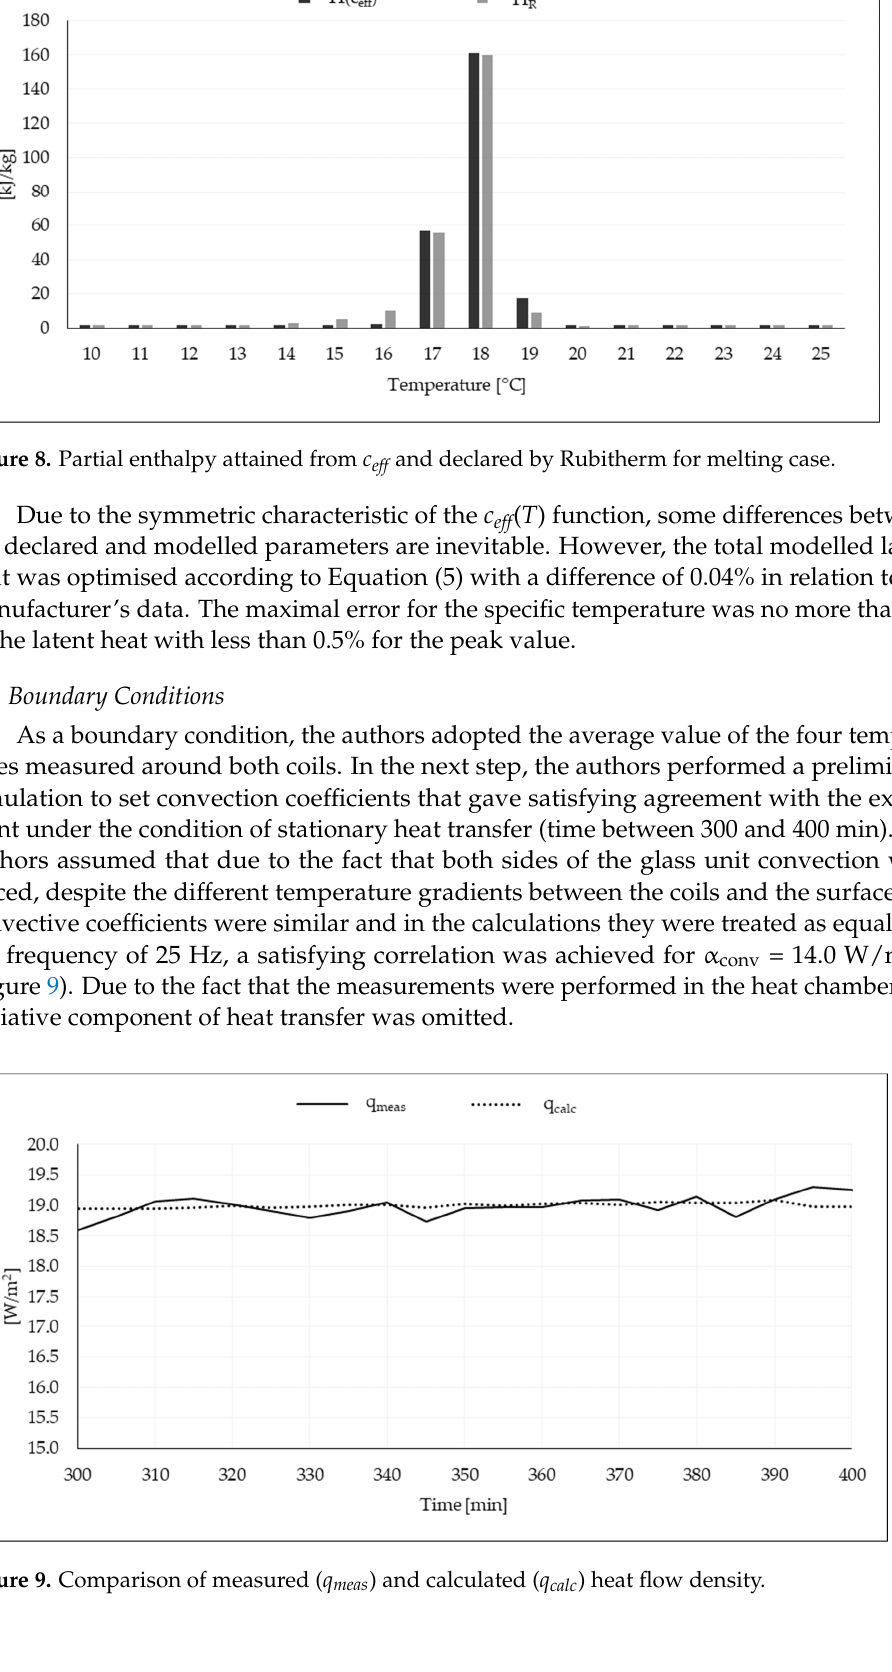
Figure 7. Effective heat capacity function used in numerical model.